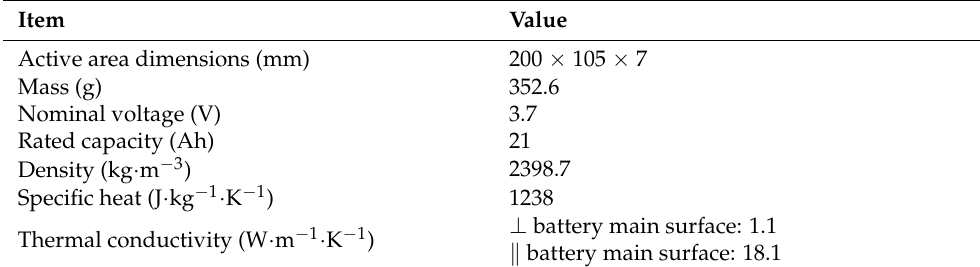
Table 1. Specifications of the LIB used in this